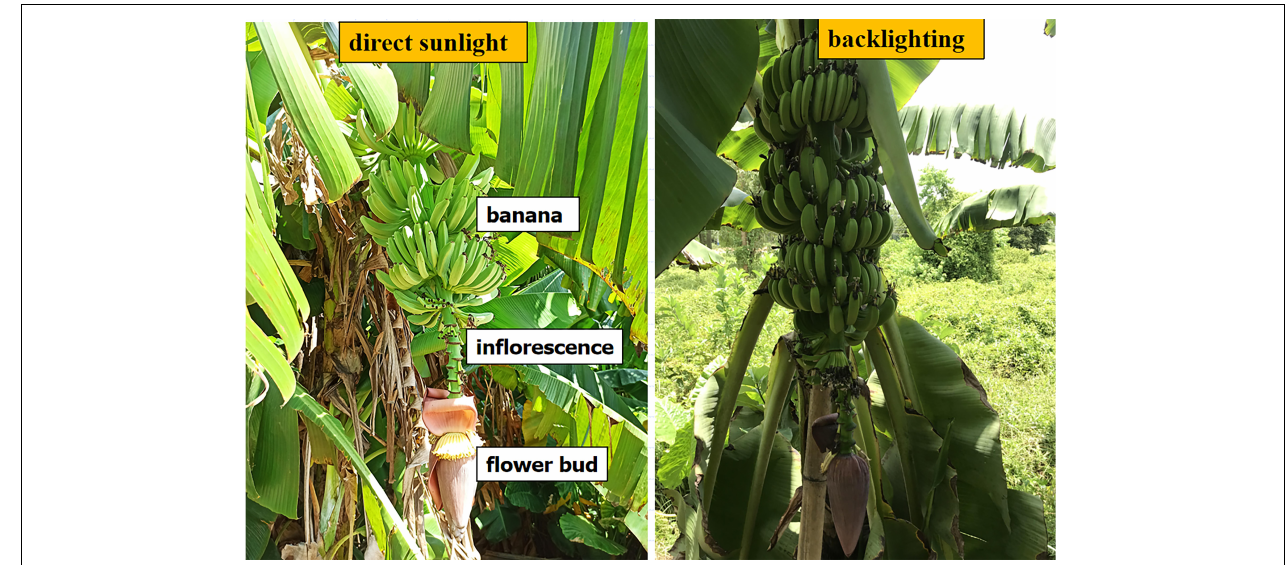
FIGURE 2 | Samples of bananas, flower buds, and inflorescence axes under front-lighting and backlighting.